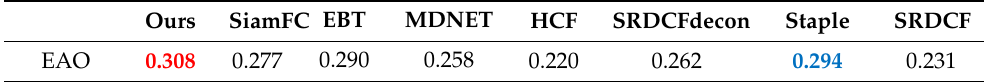
Table 3. The EAO performance comparison of ours and seven other state-of-the-art trackers on the VOT2016 dataset. The best two results are marked in red and blue bold fonts.